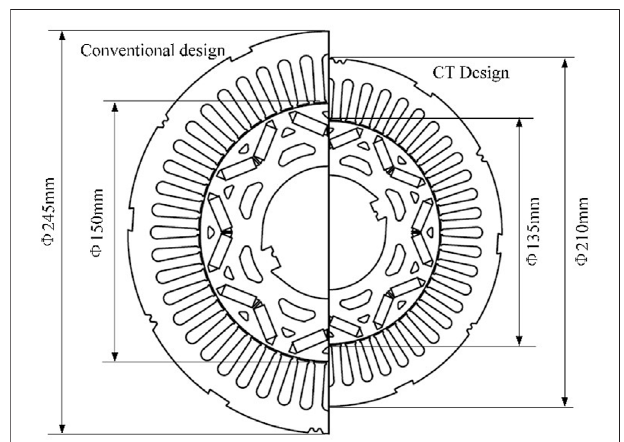
FIGURE3| DesignofthecryogenicPMSMbytheCTmethodcompared with the conventional design.